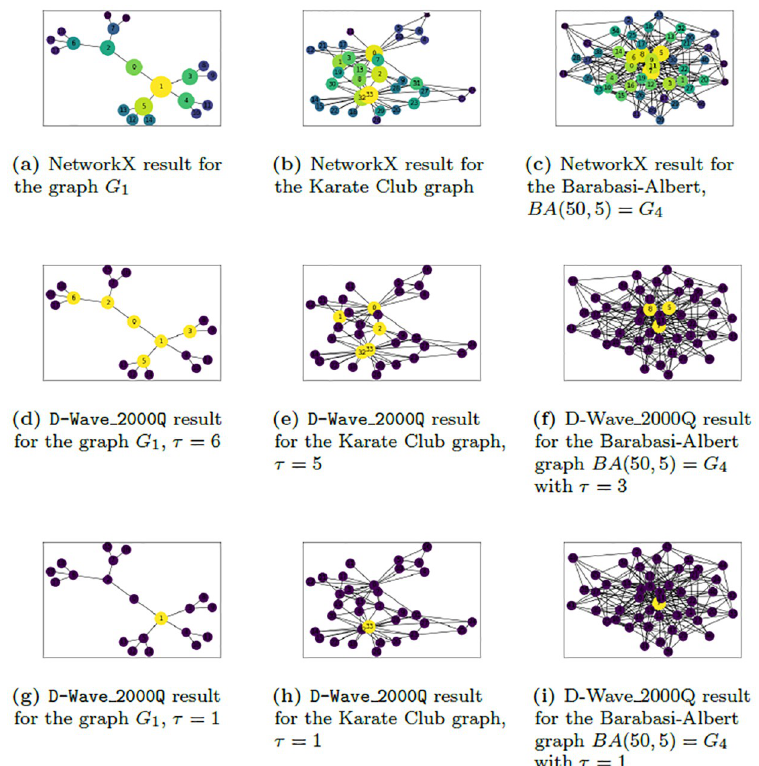
Fig 4. Results for challenging graphs. NetworkX results for the challenging graphs encountered; (a) graph G 1 , (b) Karate Club graph, and (c) Barabasi-Albert graph, BA (50, 5) = G 4 . D-Wave results obtained for the QUBO in Eq 11 using P ¼ 1 ffiffi p and P 1 = 5 n for (d) graph G 1 with τ = 6, (e) Karate Club graph with τ = 5, (f) BA (50, 5) = G 4 with τ = 3, 0 n (g) G 1 with τ = 1, (h) Karate Club graph with τ = 1 and (i) BA (50, 5) = G 4 with τ = 1. The D-Wave results colors the top τ most important nodes yellow and the least central nodes purple. The NetworkX result identifies most central nodes with larger and brighter circles (yellow being the top) and least central nodes with smaller and darker circles (least being purple).